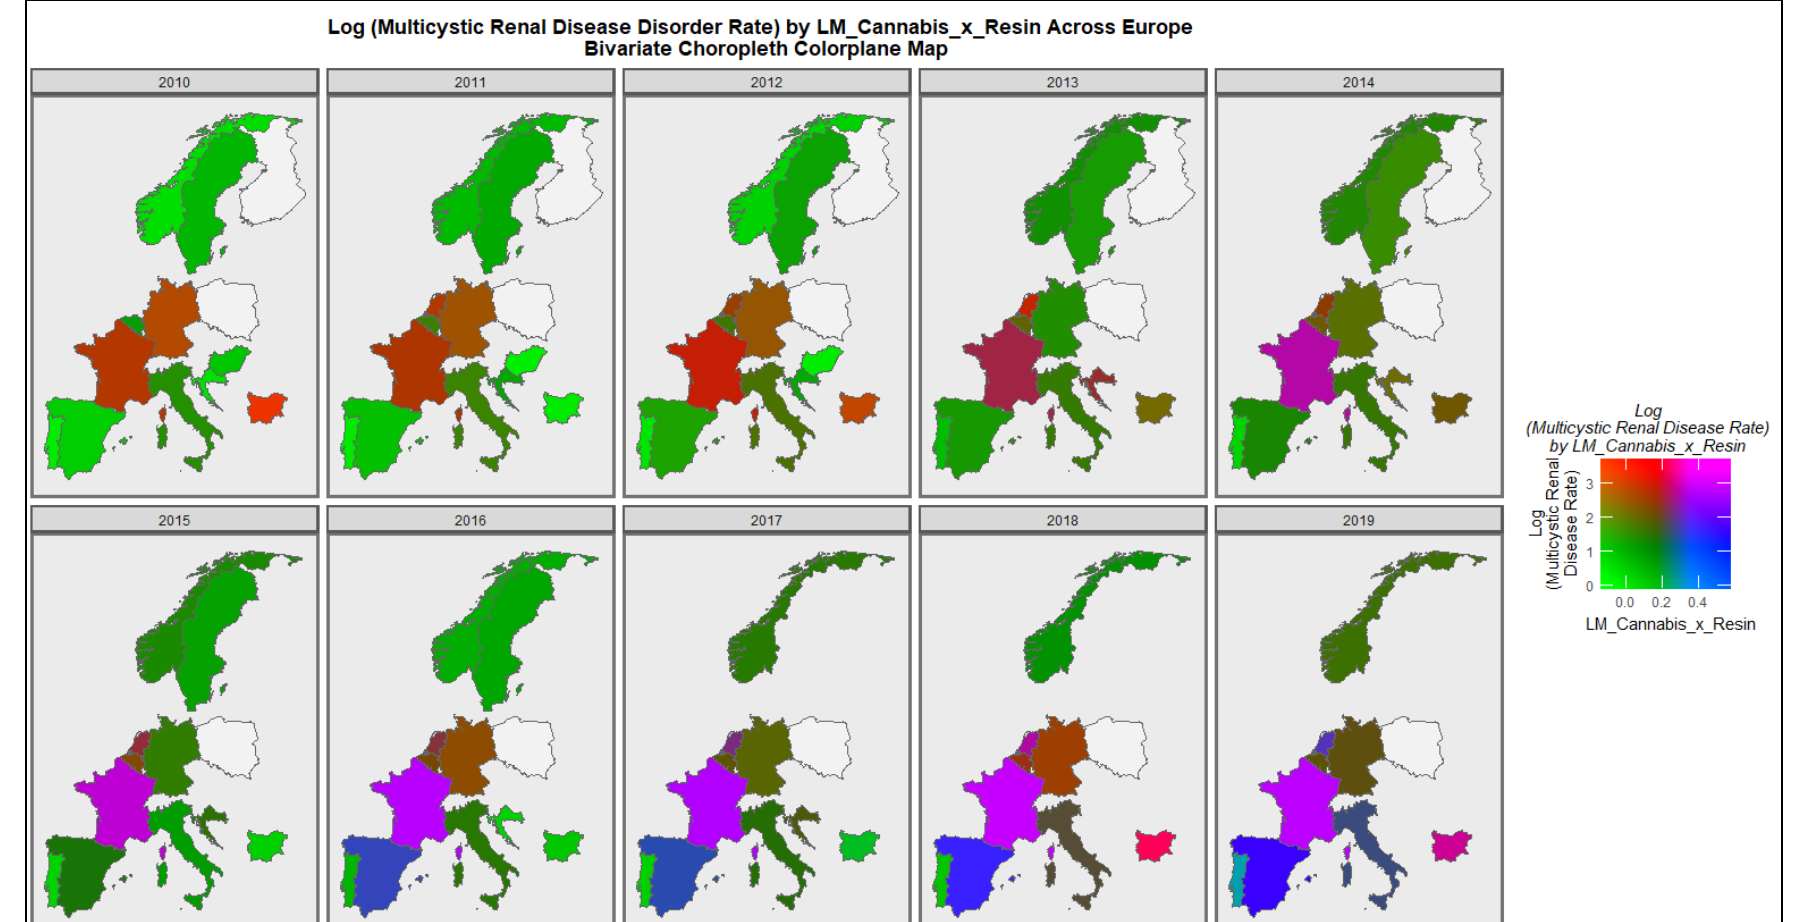
Figure 11. Colorplane bivariate time sequential map-graph of log (multicystic renal disease congenital anomaly rate) by last month cannabis use: cannabis resin THC concentration across surveyed European nations over time.